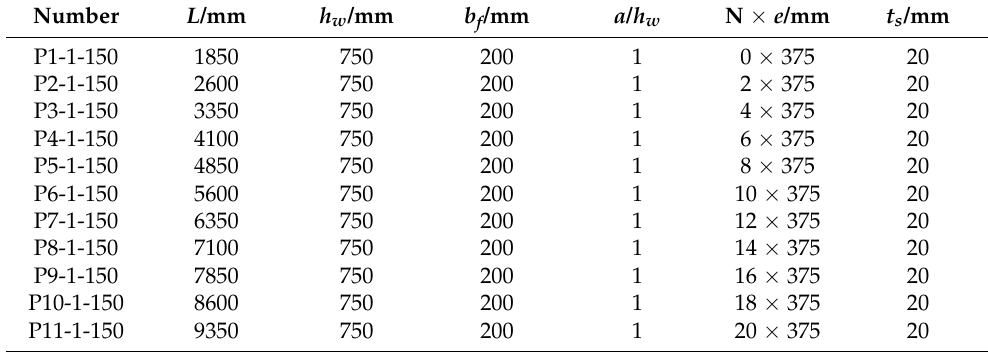
( b ) Figure 10. Failure modes of S600E s orbite SS plate girders: ( a ) P1-1-150-40; ( b ) P11-1-150-40.